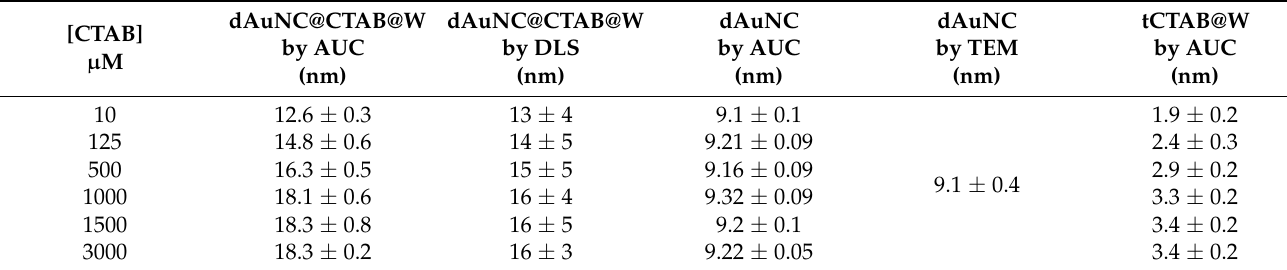
Table 2. Data obtained from the analysis of sedimentation velocity behaviour of 9 nm AuNCs using the density of Au ( ρ Au ) as a priori knowledge: hydrodynamic radius (from AUC and DLS), and AuNC size, and the thickness of hydrated CTAB and water shells (t CTAB@W